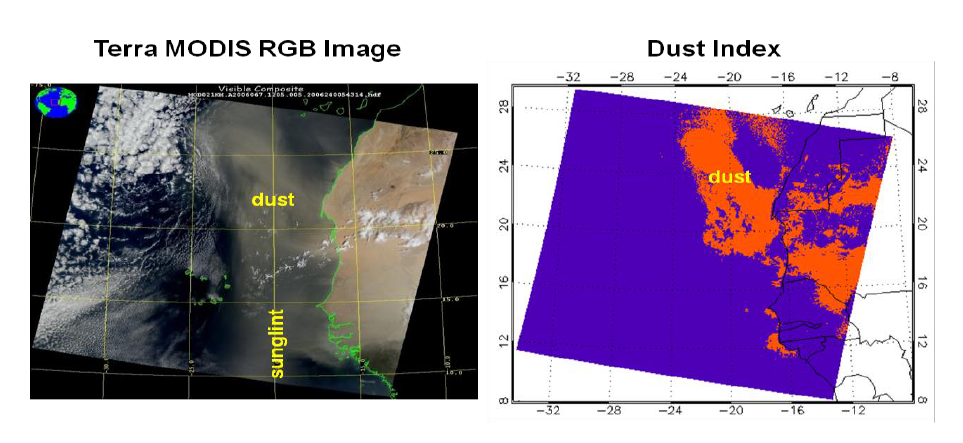
Figure 16. Terra MODIS RGB Image on March 8, 2006 at about 12:05 UTC in left panel and the results of the dust detection in right panel (pixels flagged as dusty are in red).